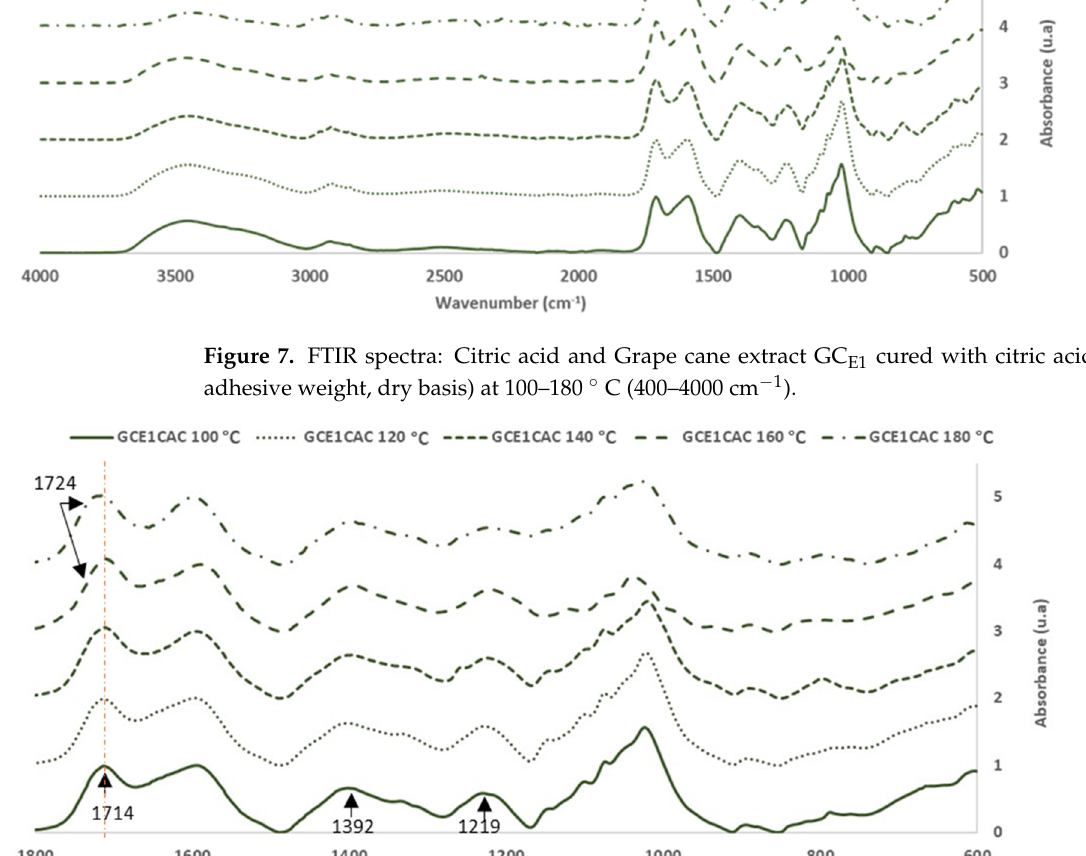
Table 6. Polymerization degree for the GC E1 + CA (33% on adhesive weight, dry basis) cured at 100 –180 °C during 120 s.